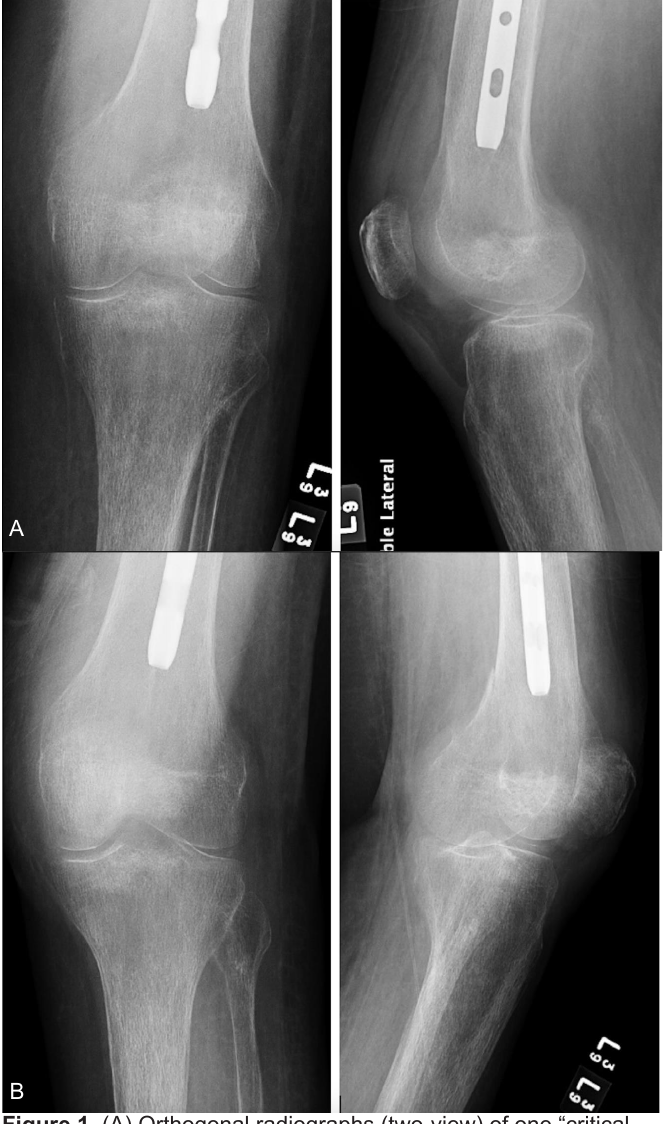
Figure 1. (A) Orthogonal radiographs (two-view) of one “critical miss” that was initially unidentified on orthogonal radiographs and then later identified as requiring operative management with the supplement of oblique radiographs. Seen to have a distal femoral metaphysis fracture. (B) Oblique radiographs (four-view component) of one “critical miss” that was not identified on orthogonal radiographs and then later identified as requiring operative management with the supplement of oblique radiographs. Seen to have a distal femoral metaphysis fracture.